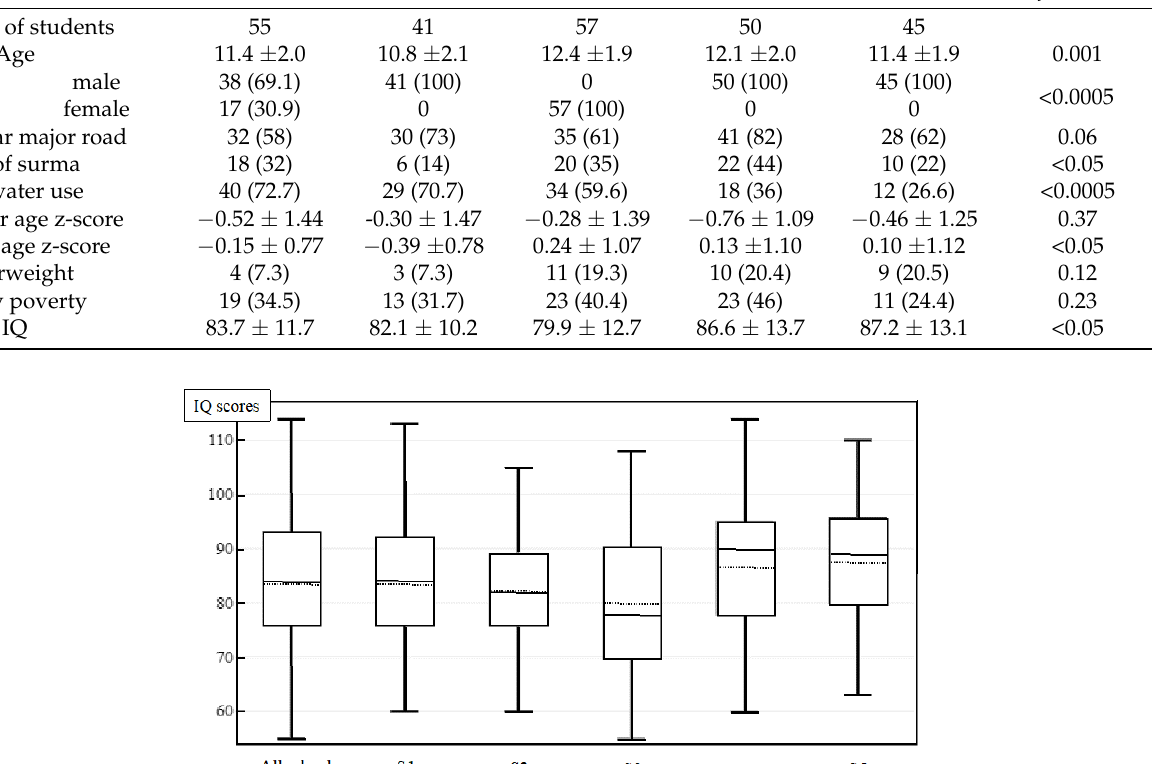
Figure 2. Box-whisker plots of children’s intellectual quotient for each school. Median (solid line). Mean (dot line).